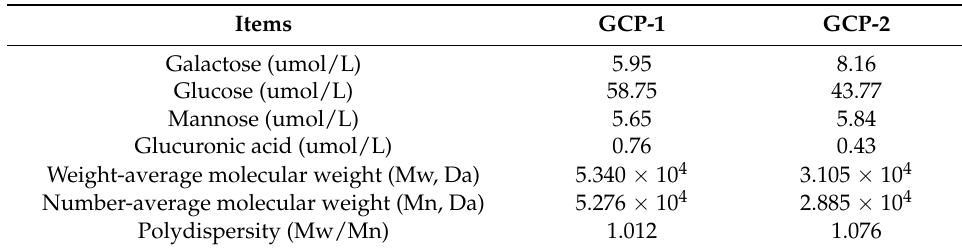
Table 1. Characteristics of GCP-1 and GCP-2 produced from glycerol and crude glycerol by C. globosum CGMCC